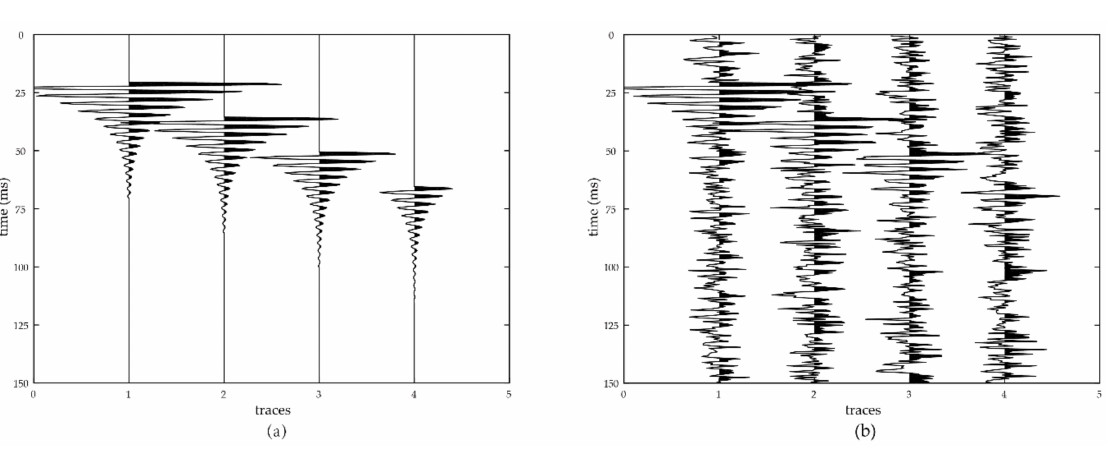
Figure 2. The waveforms of the synthetic data.